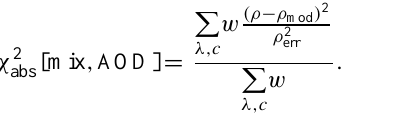
0.0 (minimum) – 180.0 (maximum). Scattering angle range varies based on µ 0 , µ . m Aerosol Mixture 74 Kahn et al. (2010) or 774 [Tables 3 and 4] ∗ Scattering Angle grids (a grid for each µ − µ 0 combination) were selected so maximum errors in the interpolated LUT values do not exceed 1% of the value compared to a 1 ◦ resolution scattering angle grid. For view zenith angle, triplets allow for changes in viewing zenith in the across-track direction. View zenith angle changes by about 17 ◦ across-track for the nadir